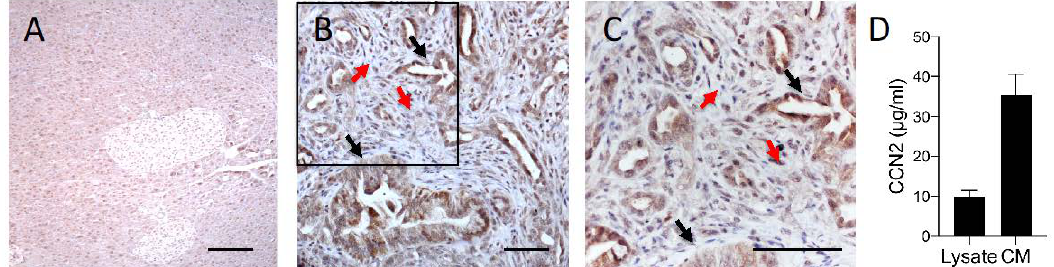
Figure 1. CCN2 is expressed by FC1199 tumors. CCN2 was analyzed by immunohistochemistry (IHC) in healthy murine pancreas ( A ) and FC1199 orthotopic tumors ( B , C ). Black arrows: tubular structures of an adenocarcinoma with cellular atypia and differences in the thickness of the tubular wall. Red arrows: stromal areas. C is a higher magnification of the boxed area in B. CCN2 was expressed by both tumor cells (black arrows) and stroma cells (red arrow), scale bars: 50 µm. ( D ) CCN2 production by FC1199 cells in vitro. CCN2 in the cell lysate and conditioned media was measured by ELISA and expressed as µg/mL.